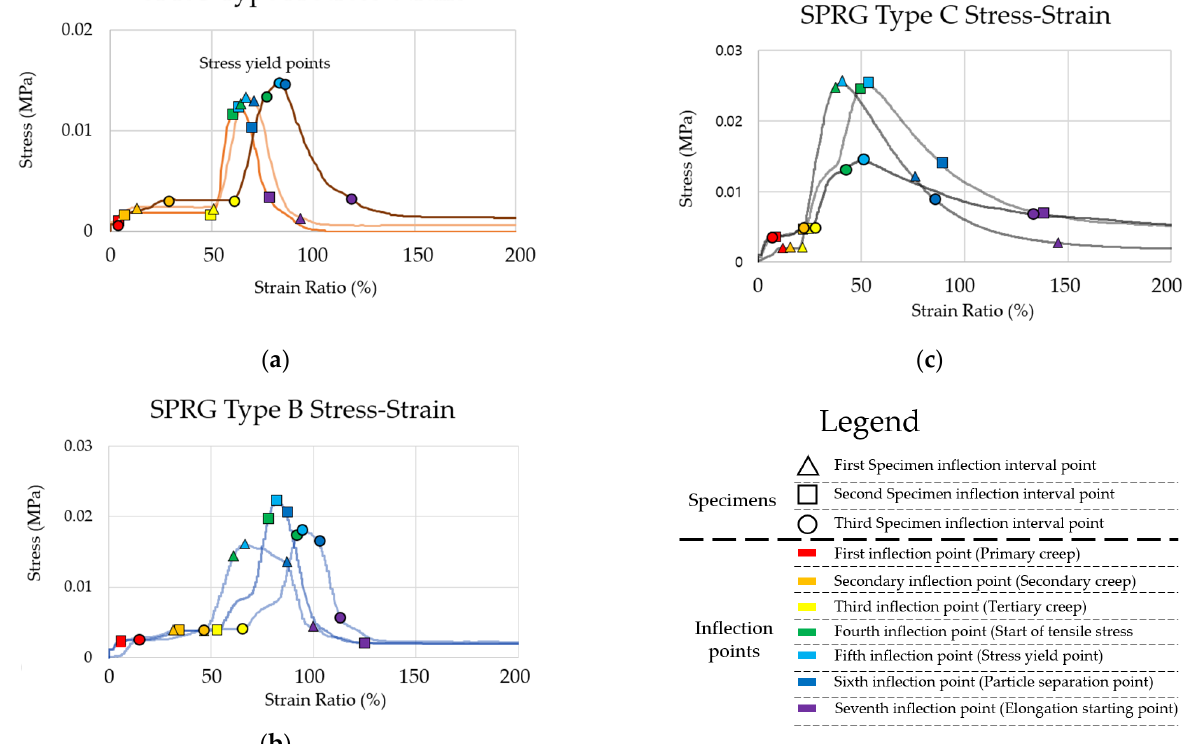
Figure 5. Stress-strain curve according to test results ( a ) SPRG Type A results, ( b ) SPRG Type B results, ( c ) SPRG Type C results.